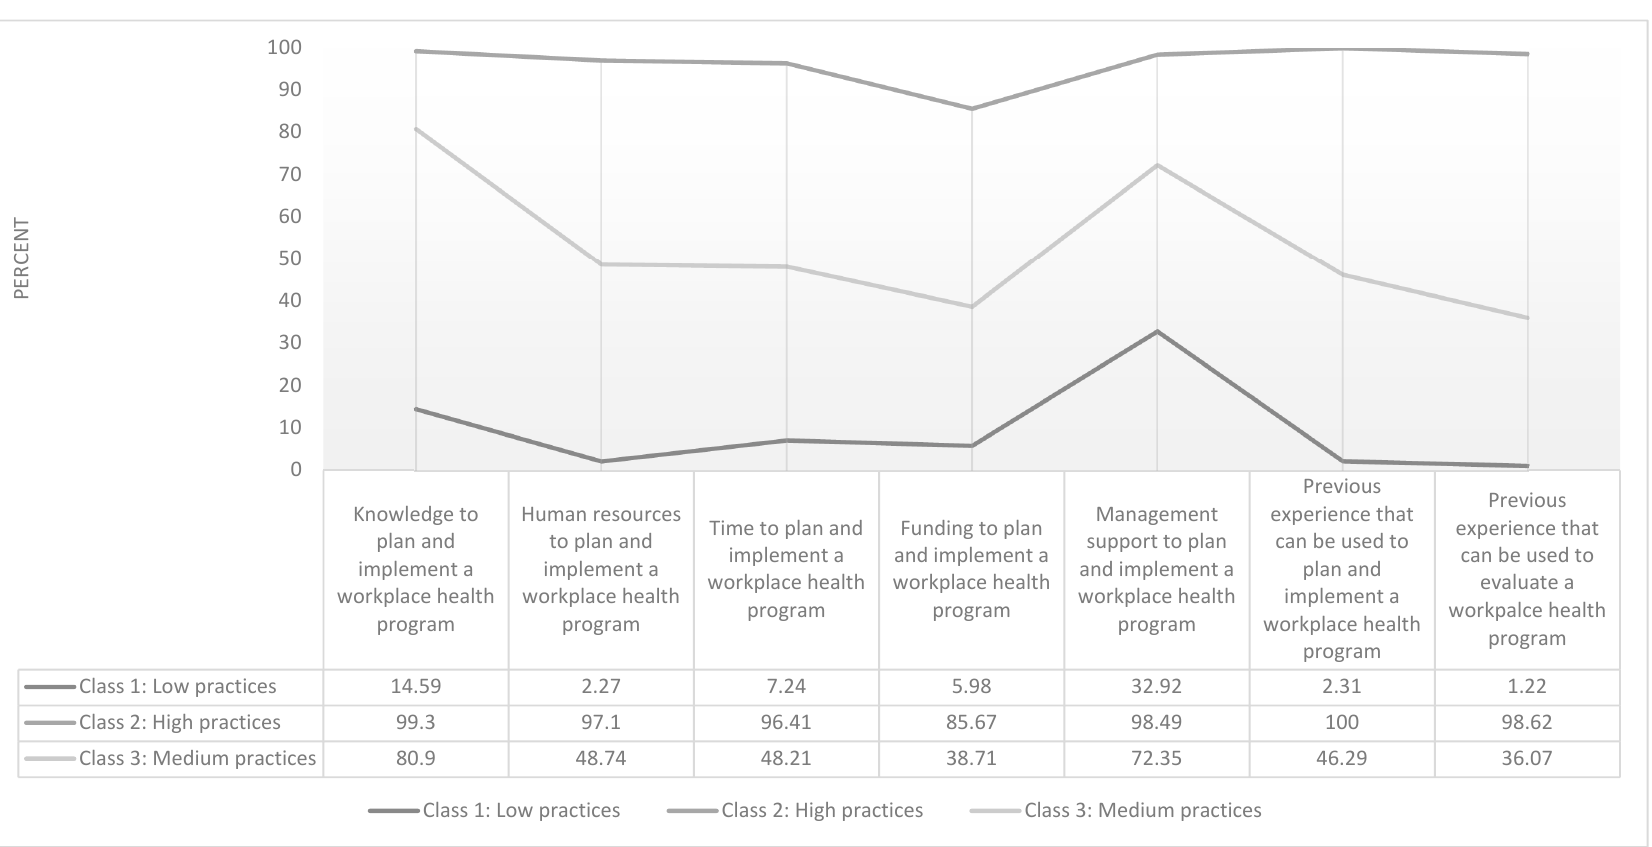
Figure 4. Percent Likelihood of Class Assignment Based on Affirmative Response to Seven WHP Practices Items (n = 528).